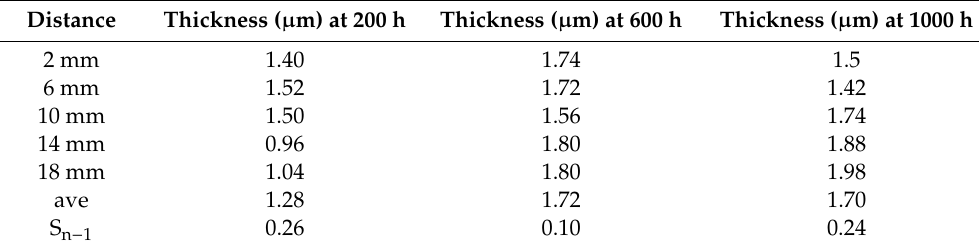
Table 5. Thickness of the corrosion layer at di ff erent times in µ